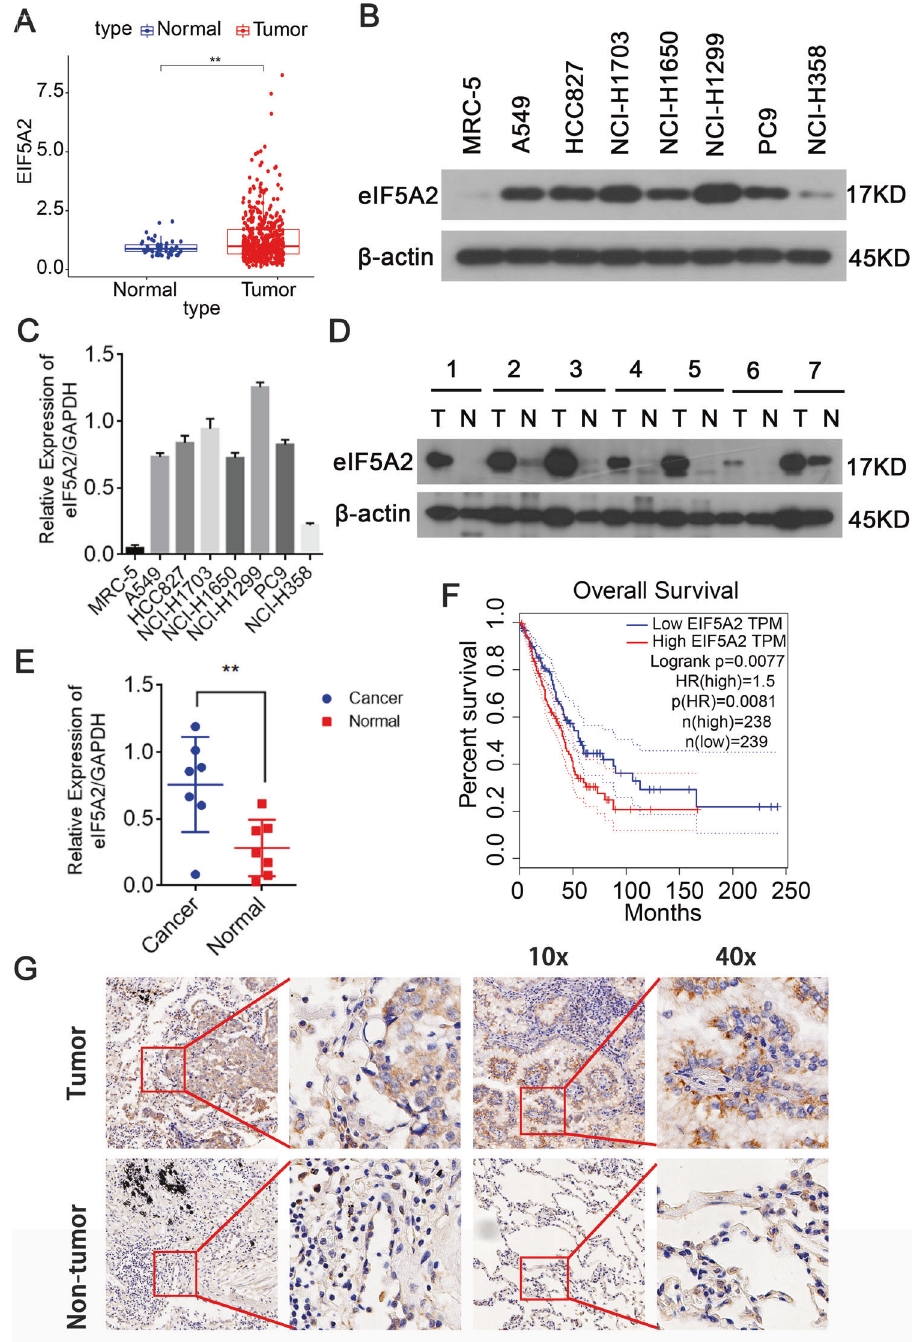
Fig. 3 EIF5A2 is highly expressed in NSCLC. A Expression analysis based on the TCGA-LUAD cohort showing that eIF5A2 expression in NSCLC tissues was signi fi cantly higher than that in adjacent normal tissues. B – E Western blotting results validating the overexpression of eIF5A2 in both NSCLC cell lines ( B , C ) and tissues ( D , E ). F Survival curve indicating that patients with NSCLC with low eIF5A2 expression always had a better survival outcomes. G IHC analysis suggesting that eIF5A2 is highly expressed in NSCLC and is located in the cytoplasm. ** P < compared with the negative control, cisplatin-induced death of EIF5A2 contributes to hypoxia-mediated cisplatin resistance A549 and NCI-H1299 cells decreased signi fi cantly after eIF5A2 in NSCLC knockdown, and increased after eIF5A2 overexpression (Fig. 4D), The high expression of eIF5A2 under hypoxia and in NSCLC indicating that eIF5A2 is involved in cell processes related to suggested that it might contribute to cisplatin resistance in cisplatin resistance in NSCLC. Next, we examined the roles of NSCLC. To test this, we reduced eIF5A2 expression using siRNAs eIF5A2 in hypoxia-induced cisplatin resistance. Compared with the targeting eIF5A2. All three siRNAs signi fi cantly reduced the mRNA negative control, the viability of si-eIF5A2 transfected A549 cells and protein levels of eIF5A2, with si-eIF5A2 presenting the treated with cisplatin under hypoxia decreased signi fi cantly, greatest silencing effects (Fig. 4A – C). CCK8 assays showed that